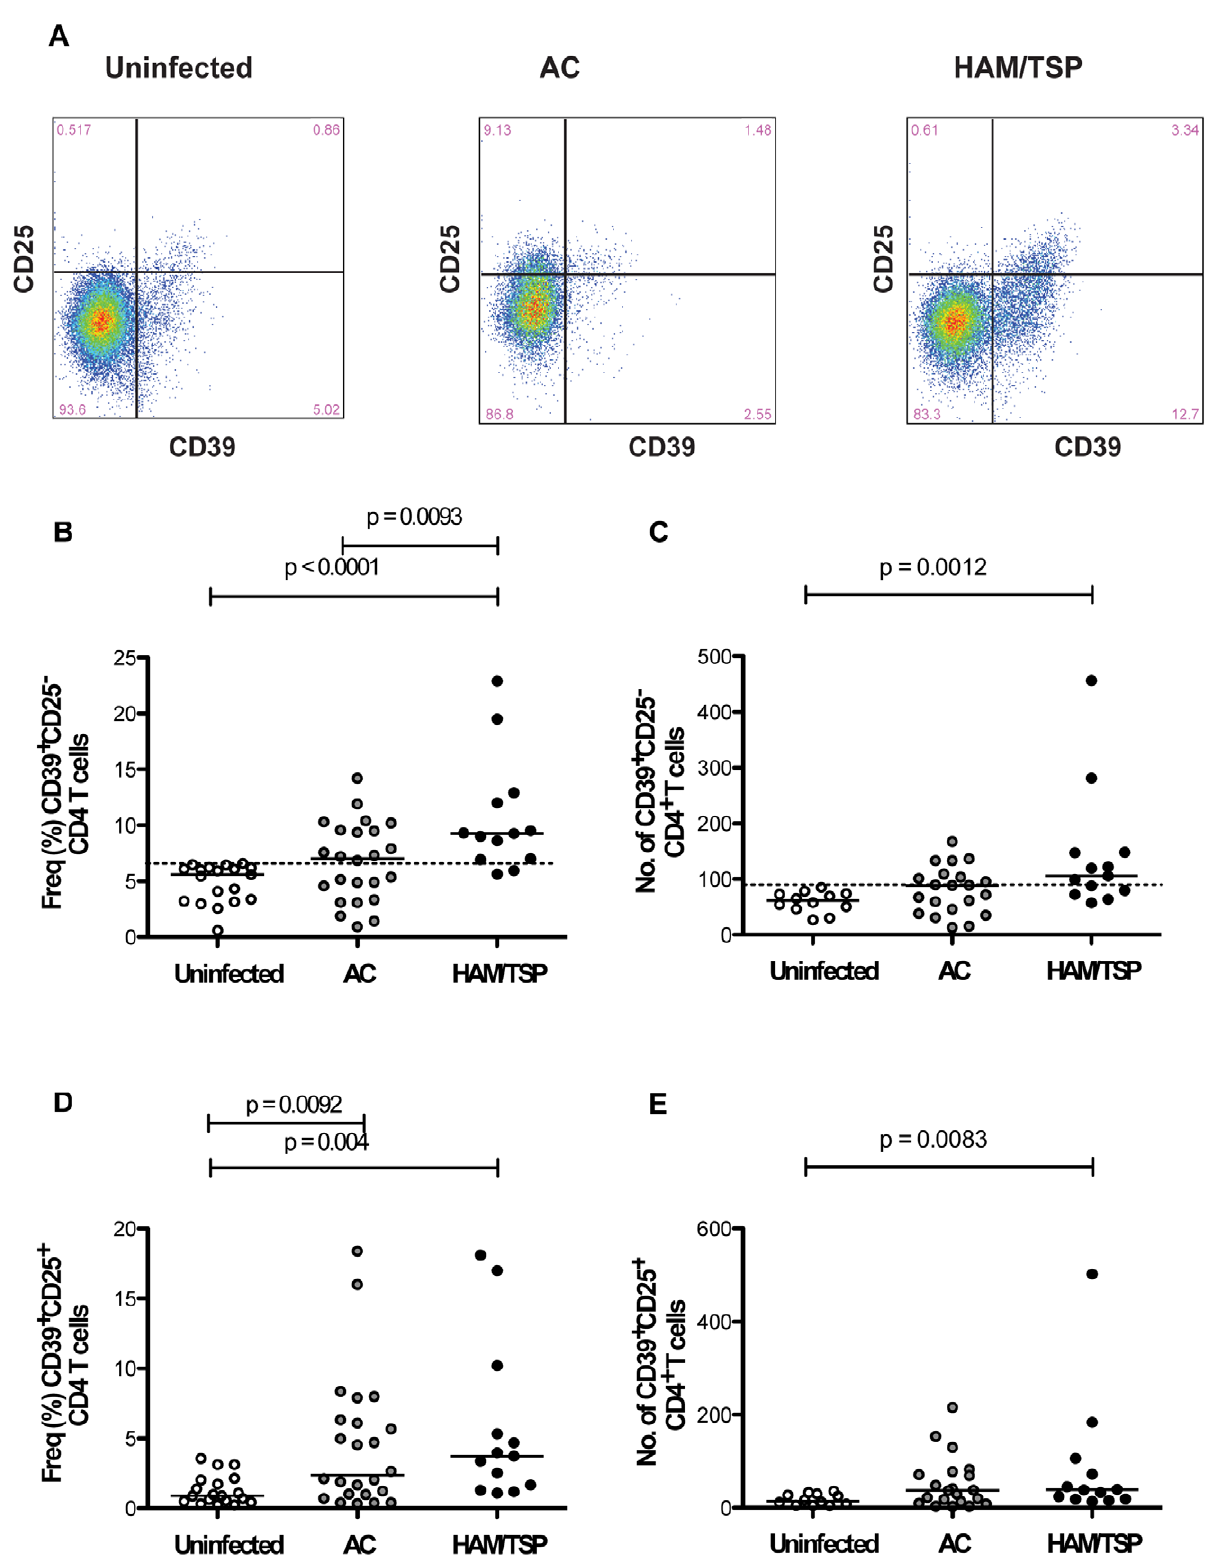
Figure 1. CD25 and CD39 expression in CD4 + T cells. Compare results from HAM/TSP patients, HTLV-1 asymptomatic carriers (AC) and uninfected subjects. The statistical difference was deemed significant using a Mann-Whitney U test analysis if p , 0.05. Horizontal bars denote median values. (A) CD39 and CD25 expression in CD4 + T cells from one representative uninfected donor, one HTLV-1-infected asymptomatic carrier and one HAM/TSP patient. (B) Proportion of CD39 + CD25 2 CD4 + T cells. Dotted line represents higher levels of CD39 + CD25 2 CD4 + T cells in uninfected subjects. (C) Number of CD39 + CD25 2 CD4 T cells. (D) Proportion of CD39 + CD25 + CD4 + T cells. (E) Number of CD39 + CD25 + CD4 + T cells. doi:10.1371/journal.pntd.0002028.g001 PLOS Neglected Tropical Diseases |